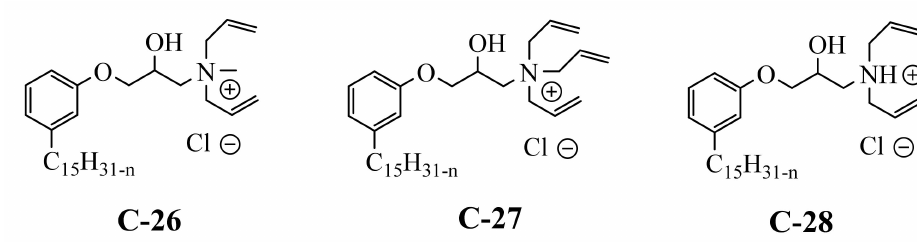
Figure 6. Ammonium surfactants derived from cardanol with allylic